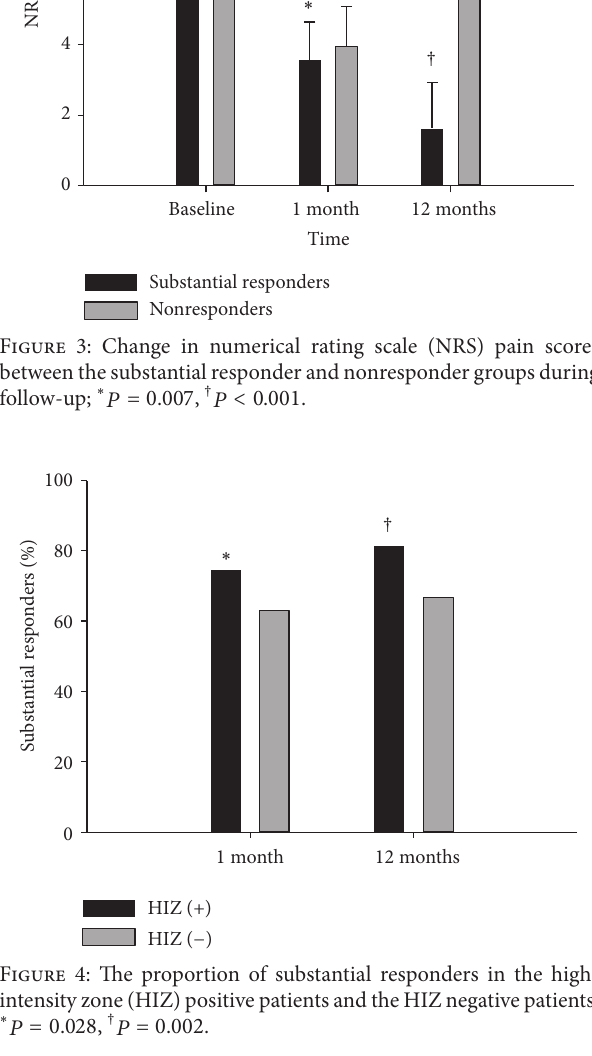
were significantly more superior compared with placebo, but the pathology of patients in that study was heterogenic [9].